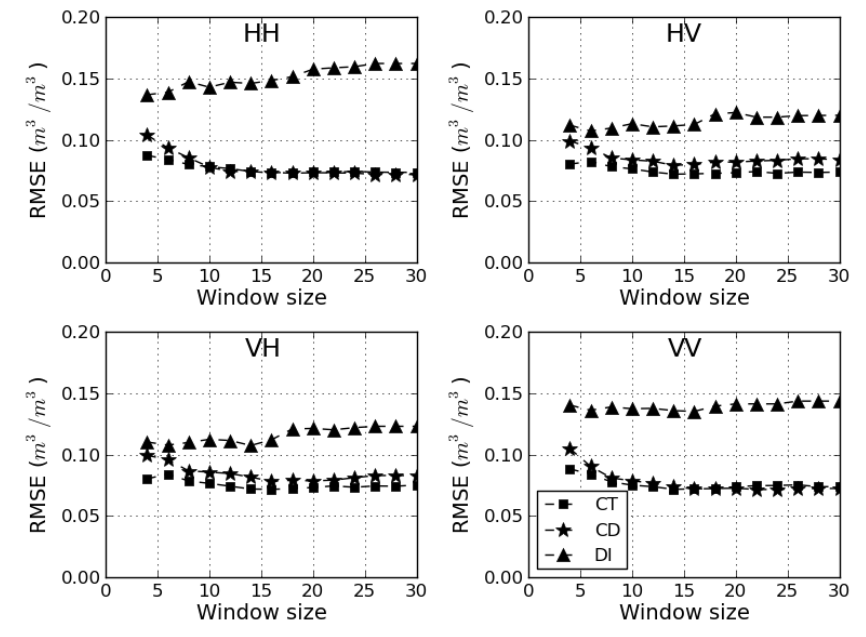
Figure 9. Effect of window size on soil moisture retrieval accuracy (CT—CDF transformation based model, CD—change detection, DI—delta